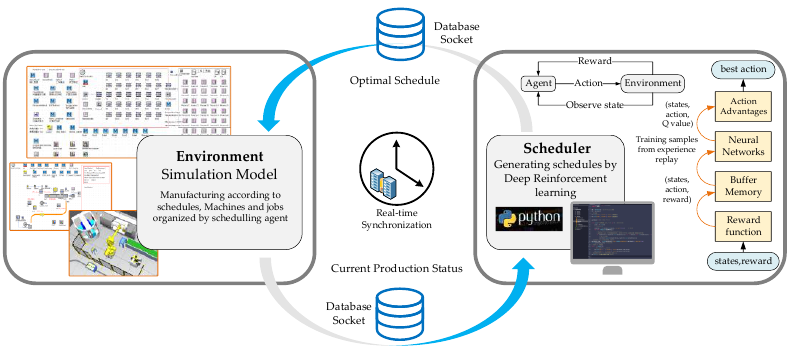
Figure 6. Real-time interaction of agent with scheduling environment.